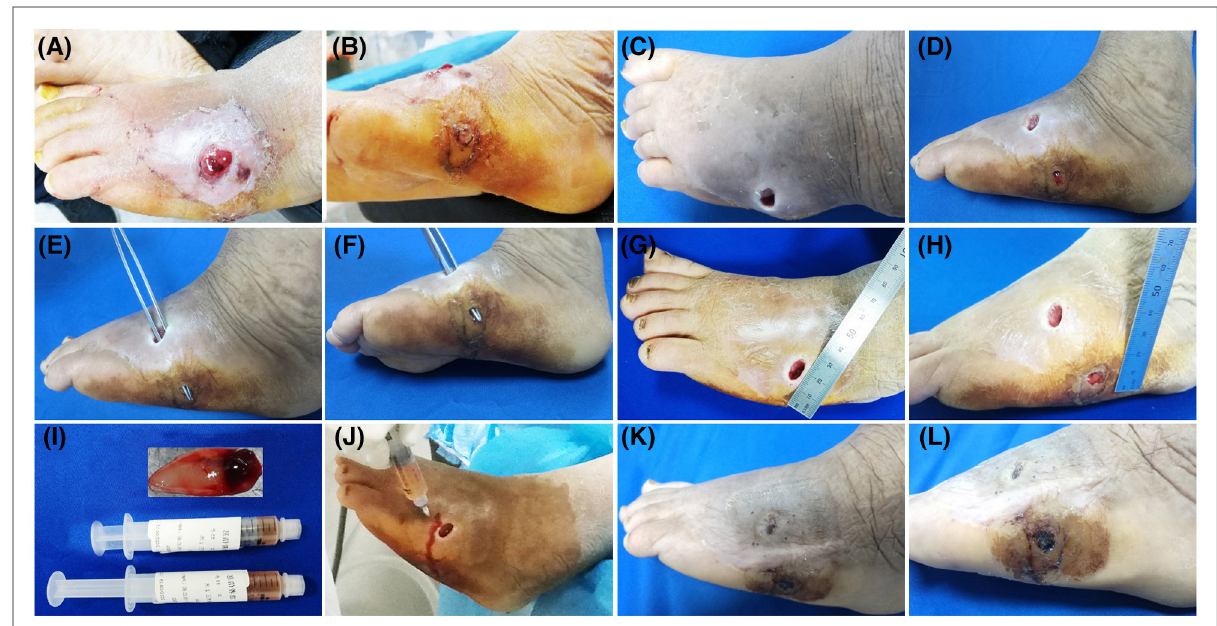
FIGURE 3 Patient 3. A 55-year-old female developed a fi stula in the left lateral foot for 8 months. ( A – D ) Baseline. Diabetic foot, Wagner grade 2. ( E – H ) The wound was clean after debridement. The fi stula was explored with sterile surgical forceps. ( I ) Treatment day. The prepared PRP and PRF. ( J ) Treatment day. The wound bed was injected with PRP. ( K,L ) 28 days after the combined